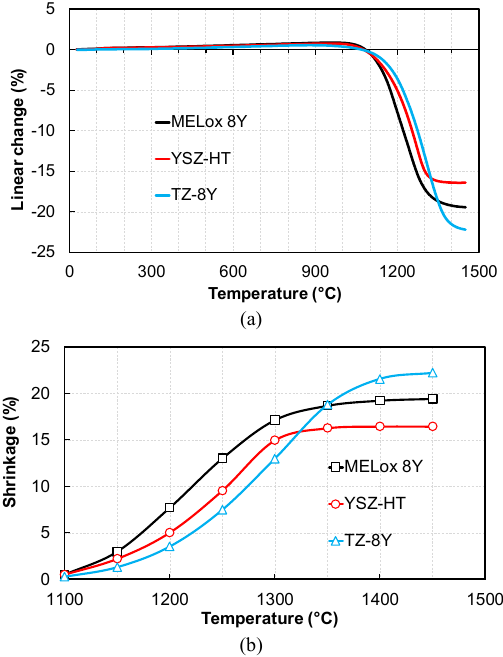
Fig. 4 Dilatometry results for the YSZ powders: (a) linear change versus sintering temperature; (b) comparison of shrinkage between 1100 and 1450 ℃ .